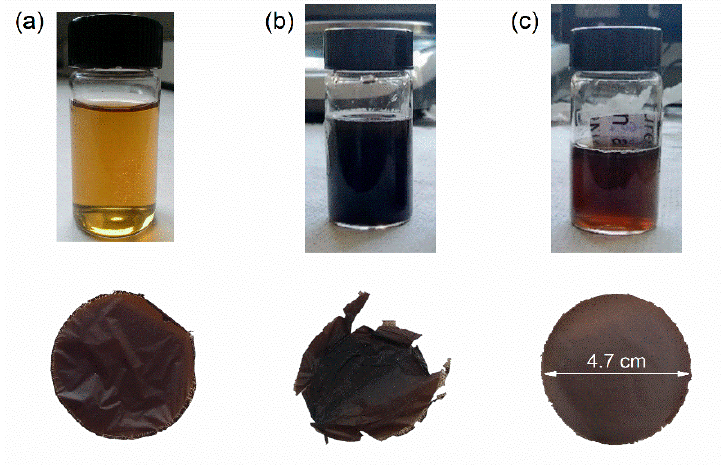
Figure 1. Images of the formulations and f-GO membranes with the binders ( a ) GO, ( b ) PVDF, and ( c )